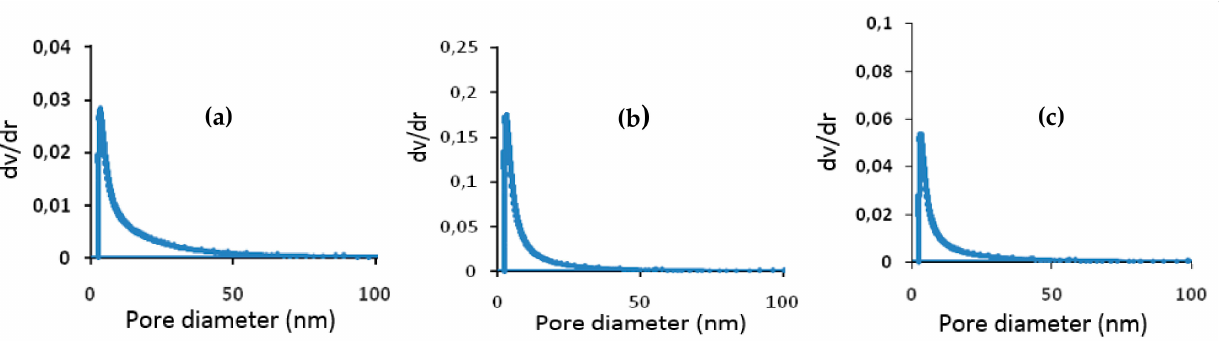
Figure 7. Distribution of pore diameters for the composite membranes ( a ) A85, ( b ) A50; ( c )